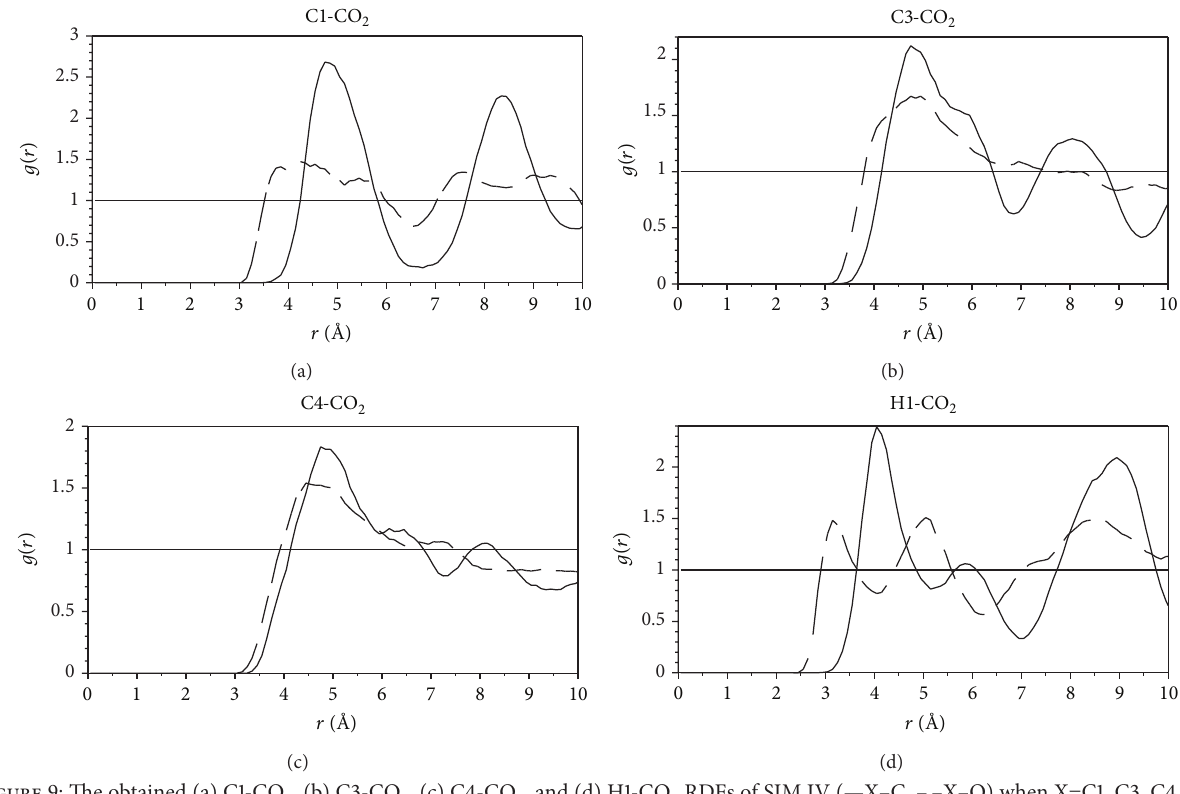
Figure 9: The obtained (a) C1-CO 2 , (b) C3-CO 2 , (c) C4-CO 2 , and (d) H1-CO 2 RDFs of SIM IV (—X–C, ––X–O) when X=C1, C3, C4, and H1, respectively.